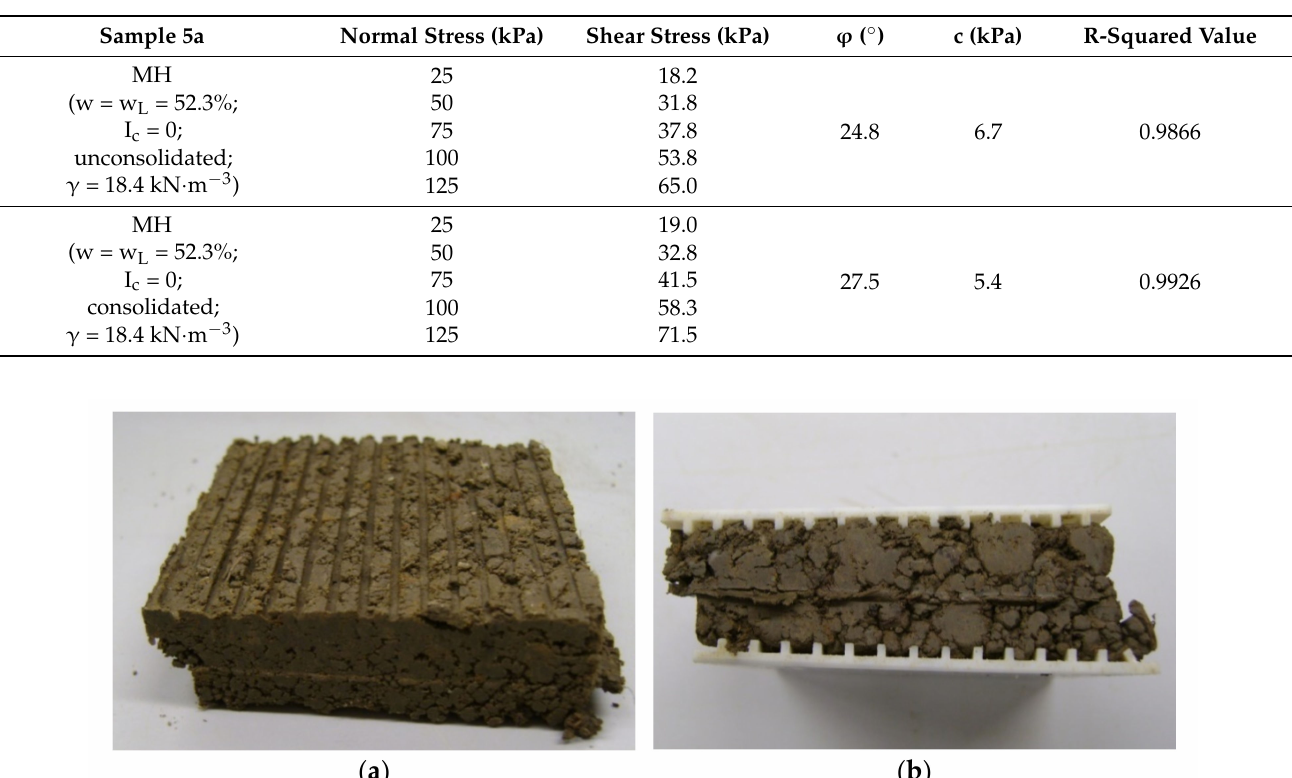
Figure 10. Soil samples after shearing (state of sampling day). ( a ) Sample from location 4, after shearing at a normal stress of 100 kPa; ( b ) sample from location 5, after shearing at a normal stress of 50 kPa.